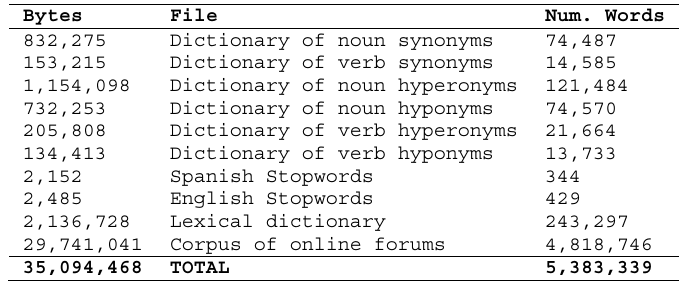
Table 1. Description of the datasets used in the